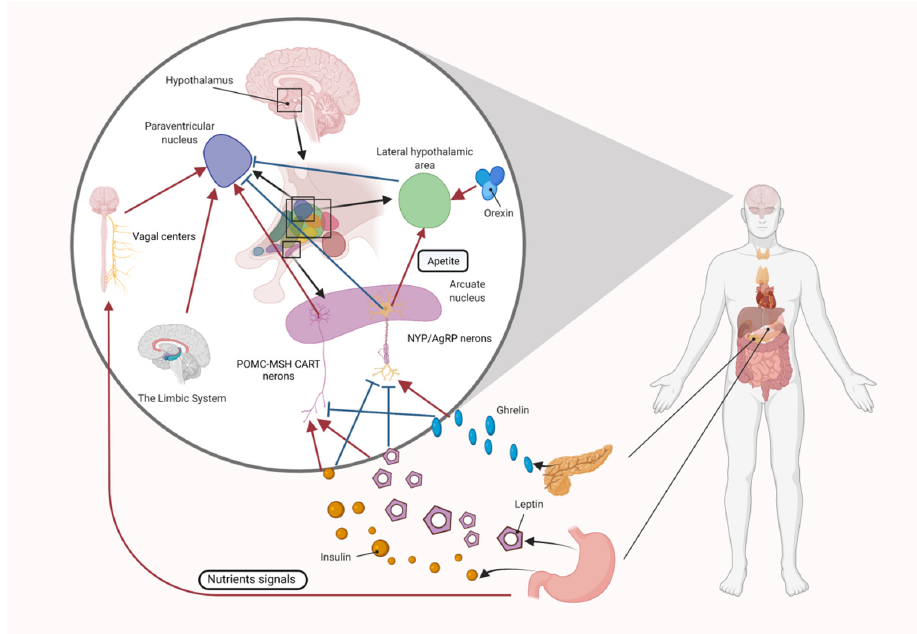
Figure 1. Central regulatory mechanisms of appetite. POMC-MSH neurons and NYP/AgRP